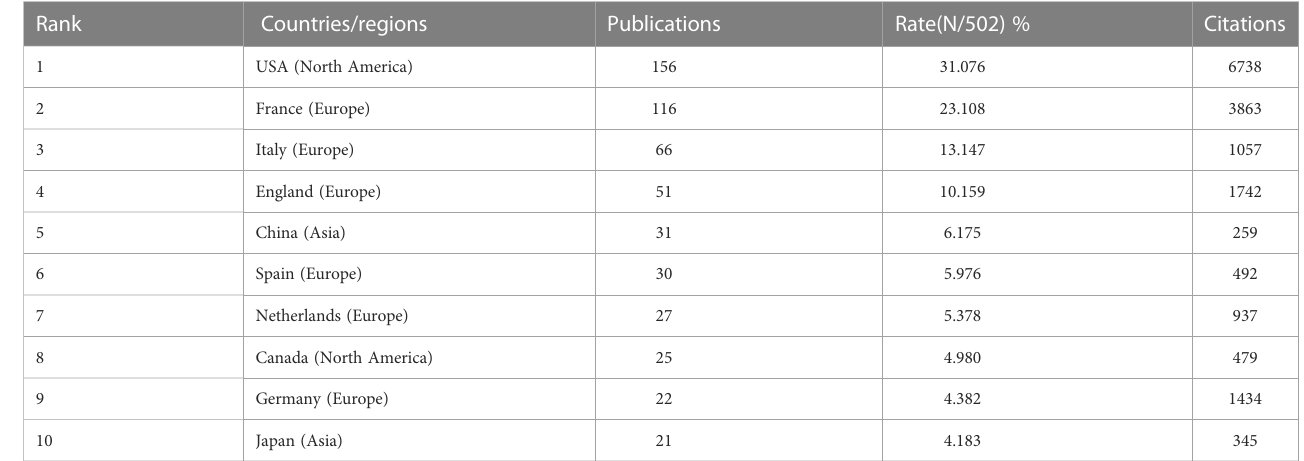
TABLE 1 Top 10 countries/regions with the most publications in pharmacovigilance and cancer. Rank Countries/regions